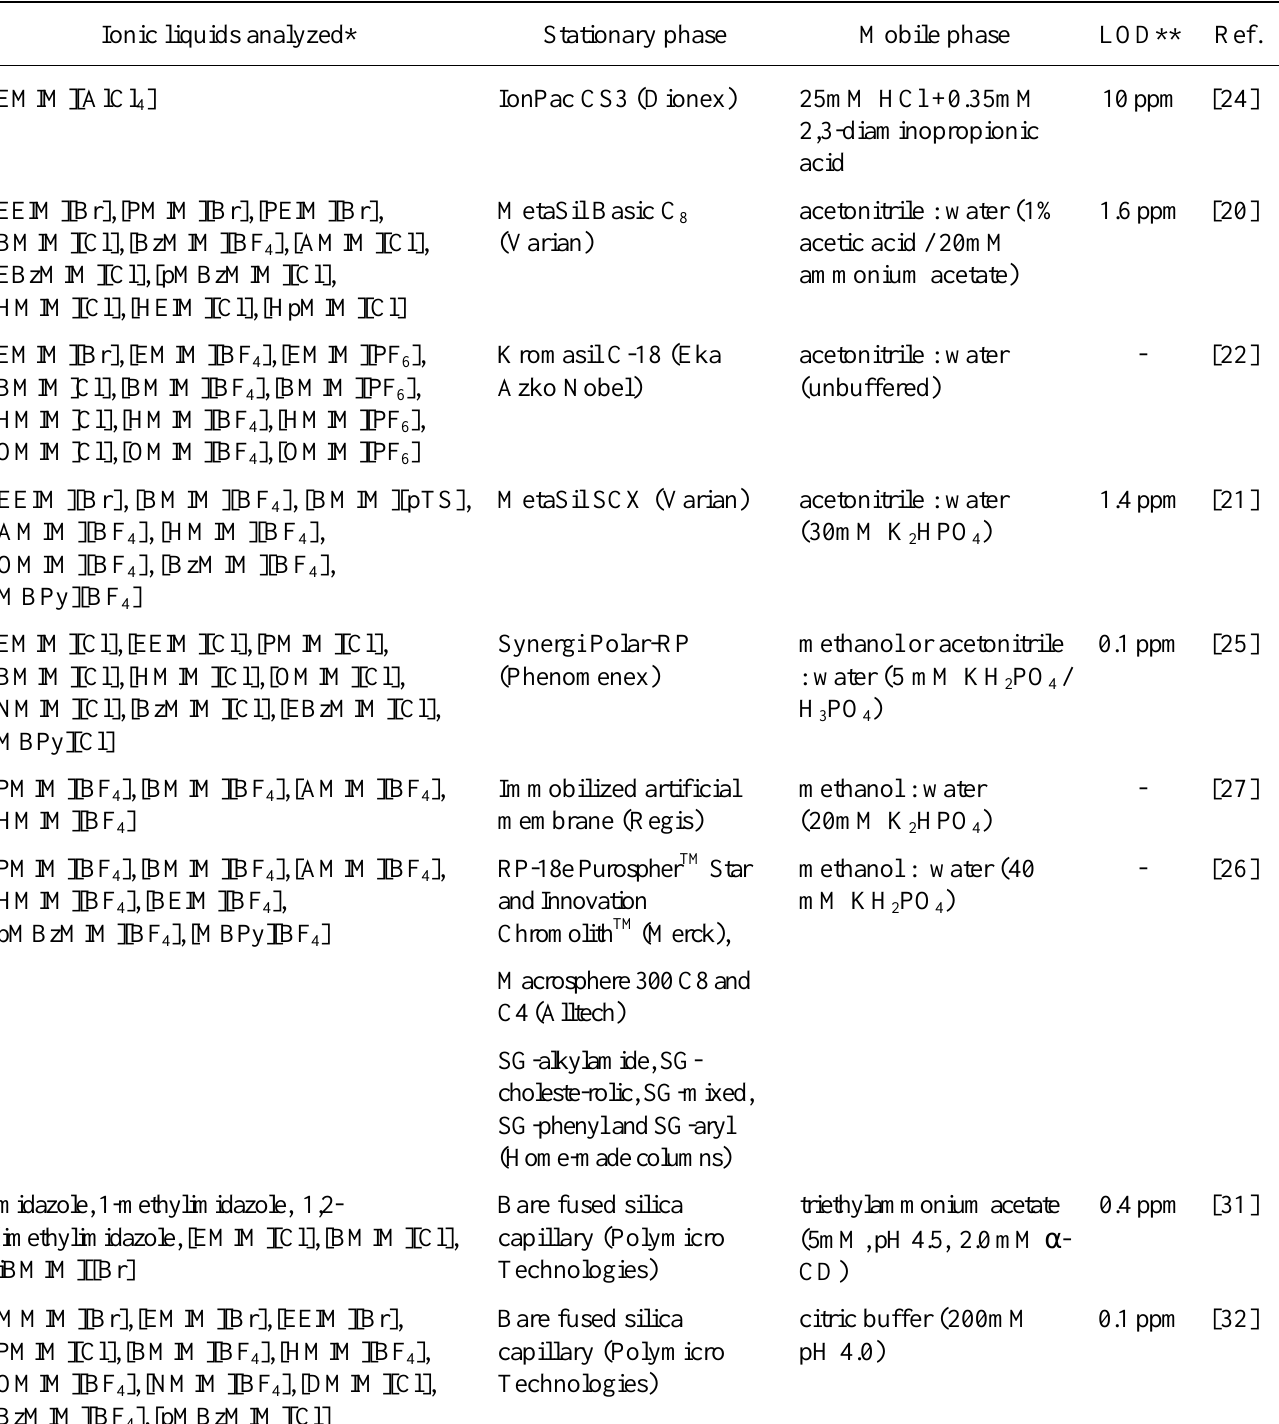
Table 3. Chromatographic and capillary electrophoretic methods used for separation and analysis of